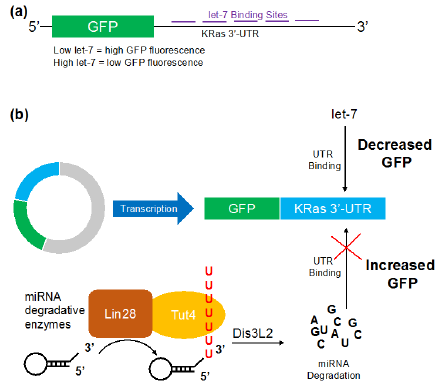
Figure 1. Schematic of the microRNA (miRNA) activity reporter (MiRAR) for let-7 levels in vivo. The KRas 3′ -UTR was fused downstream of green fluorescence protein (GFP) to allow quantification of cellular let-7 levels. ( a ) Schematic of pMiRAR-let-7 construct; ( b ) miRNA degradative enzymes Lin28 and Tut4 collaborate to mark let-7 miRNA for degradation by the exonuclease Dis3L2. The RNA binding protein Lin28 recruits Tut4 to polyuridylate miRNA and pre-miRNAs, leading to degradation by the U-specific exonuclease Dis3L2. Lowered miRNA levels lead to an increase in GFP translation and fluorescence. KRas: Kirsten rat sarcoma viral oncogene homolog, UTR: untranslated region.